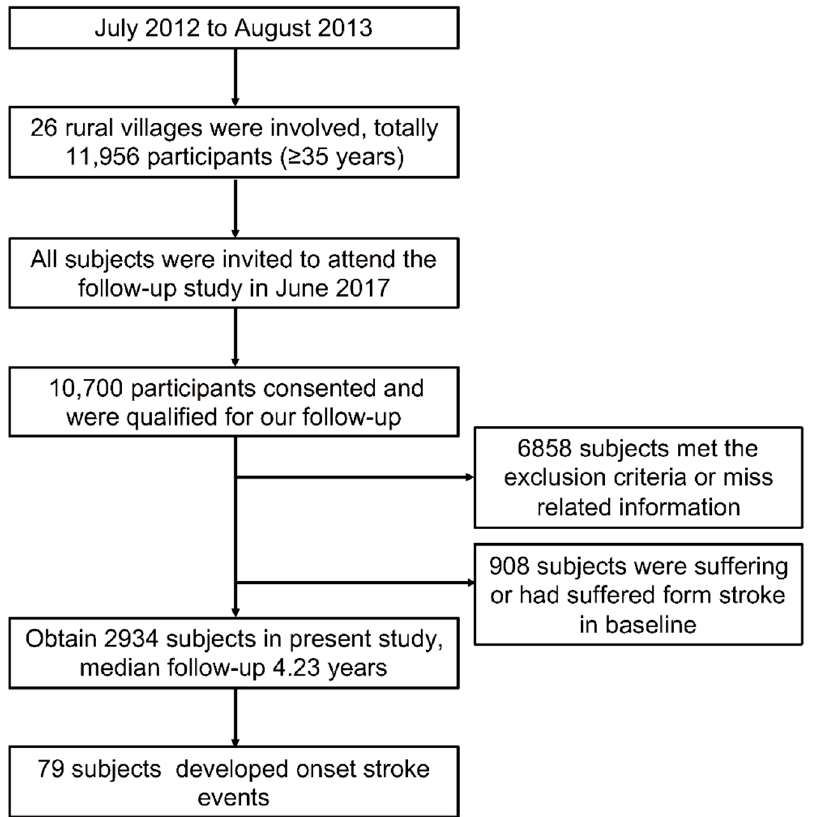
Figure 1. Flow chart of our study population’s selected protocol. We recruited a total of 11,956 natural residents (age ≥ 35 years) from rural regions in three counties in northeastern China. In 2017, 10,700 participants consented and were qualified for our follow-up study. In the present study, we excluded 6858 participants who lacked related information or missed the follow-up and further excluded 908 participants who were suffering or had suffered from stroke in baseline. Eventually, we obtained a target population of 2934 for the present study.